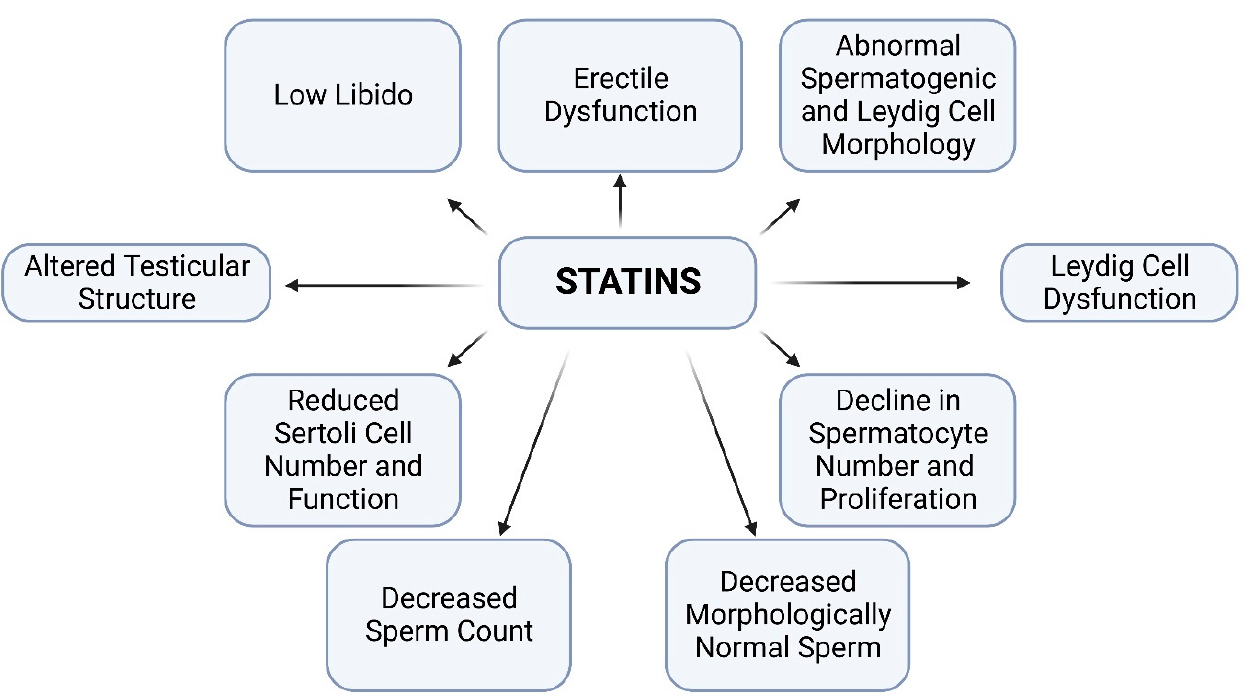
Figure 2. The summarized effects of statins on male sexual health and reproductive parameters. It is important to note that not all studies on the different forms of statins reported these adverse ef- fects.